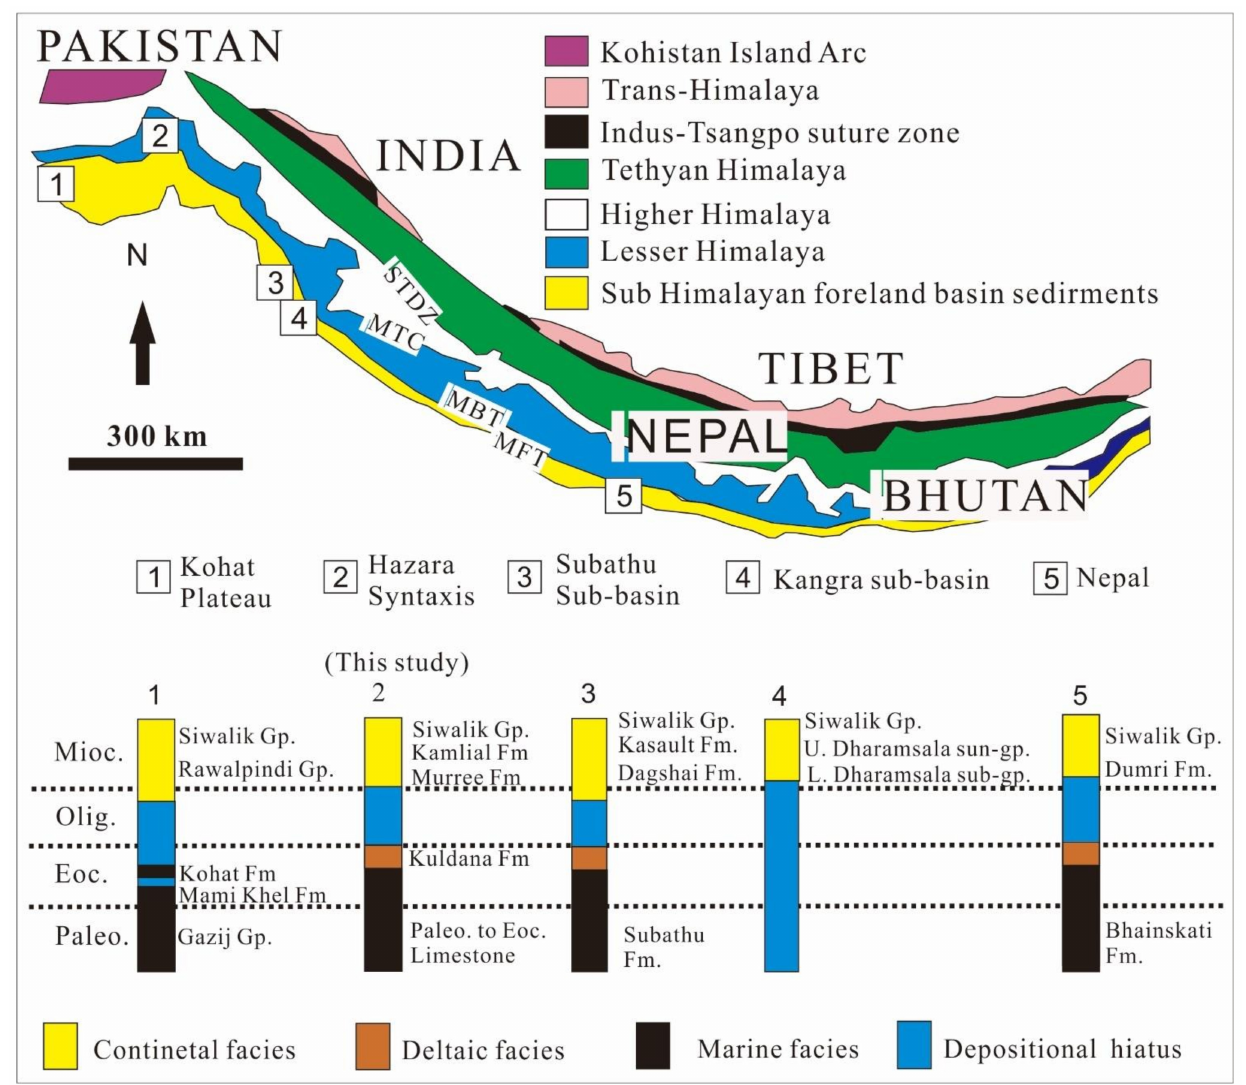
Figure 2. Outcrop locations and lithological correlation map of the Kuldana Formation with strati- graphic equivalent formations in the Himalayan range (Pakistan, India, and Nepal; Modified after